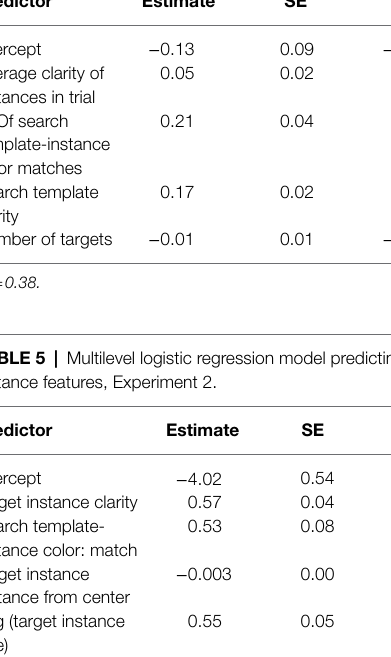
TABLE 4 | Linear regression model predicting true positive rate from trial features, Experiment 2. Predictor